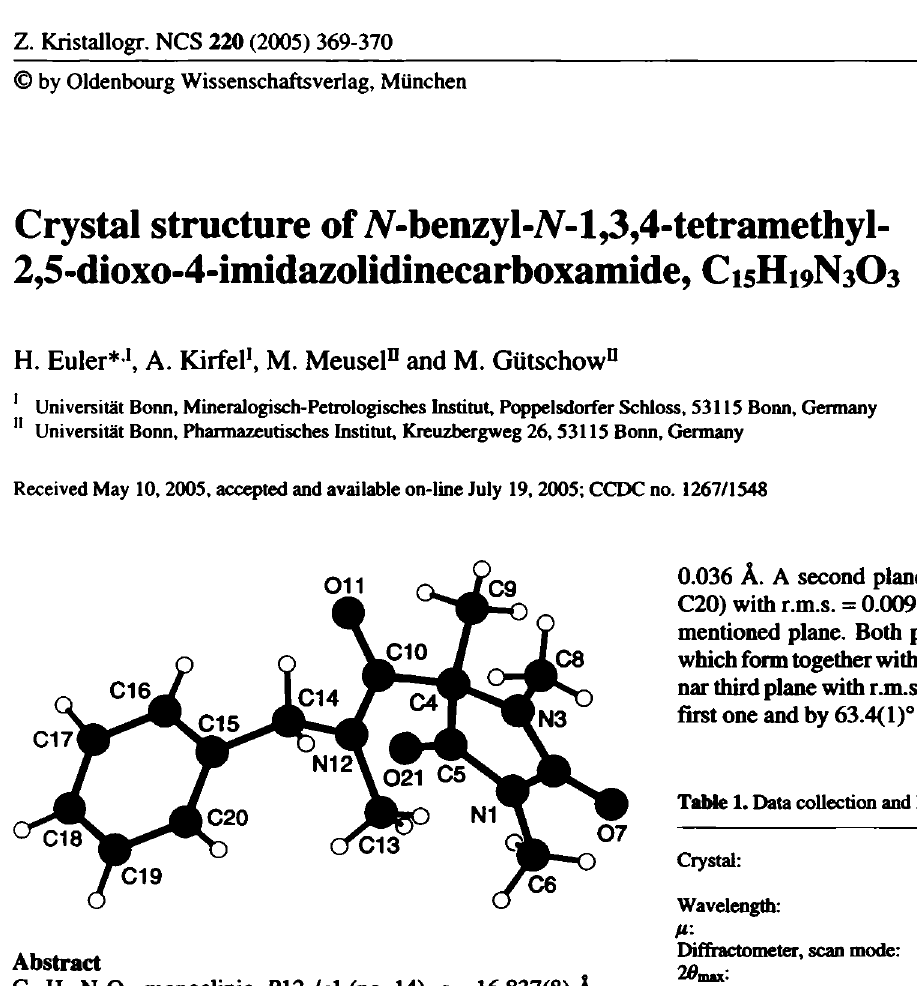
Table 1. Data collection and handling.